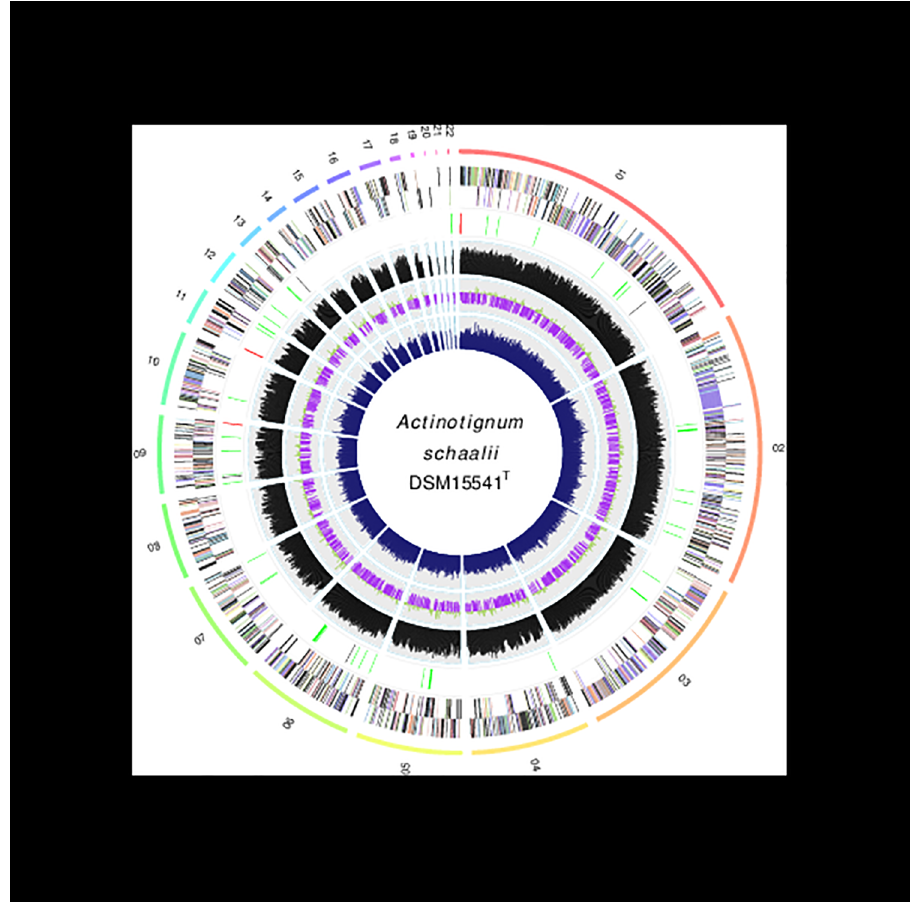
Fig 1. Circular representation of A . Schaalii DSM15541 T genome (27 scaffolds). Features from the outer circle to the center are: geneson the forward strand (color by COG categories), geneson the reverse strand (color by COG cataegories), RNA genes (tRNA green, rRNA red, other RNAs black), % G+C content, GC skew (purple/olive) and codon adaptation index. The figure was obtained using OmicCircos [36].